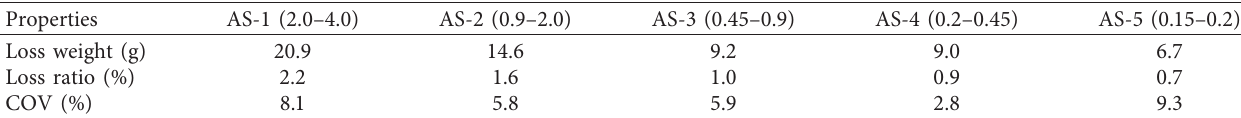
Figure 4: Construction of sand fog seal: (a) pretreatment of the old pavement; (b) surface grinding; (c) sand fog seal spraying; (d) preservation after sealing. Table 4: Abrasion loss of sand fog seal of different aggregate